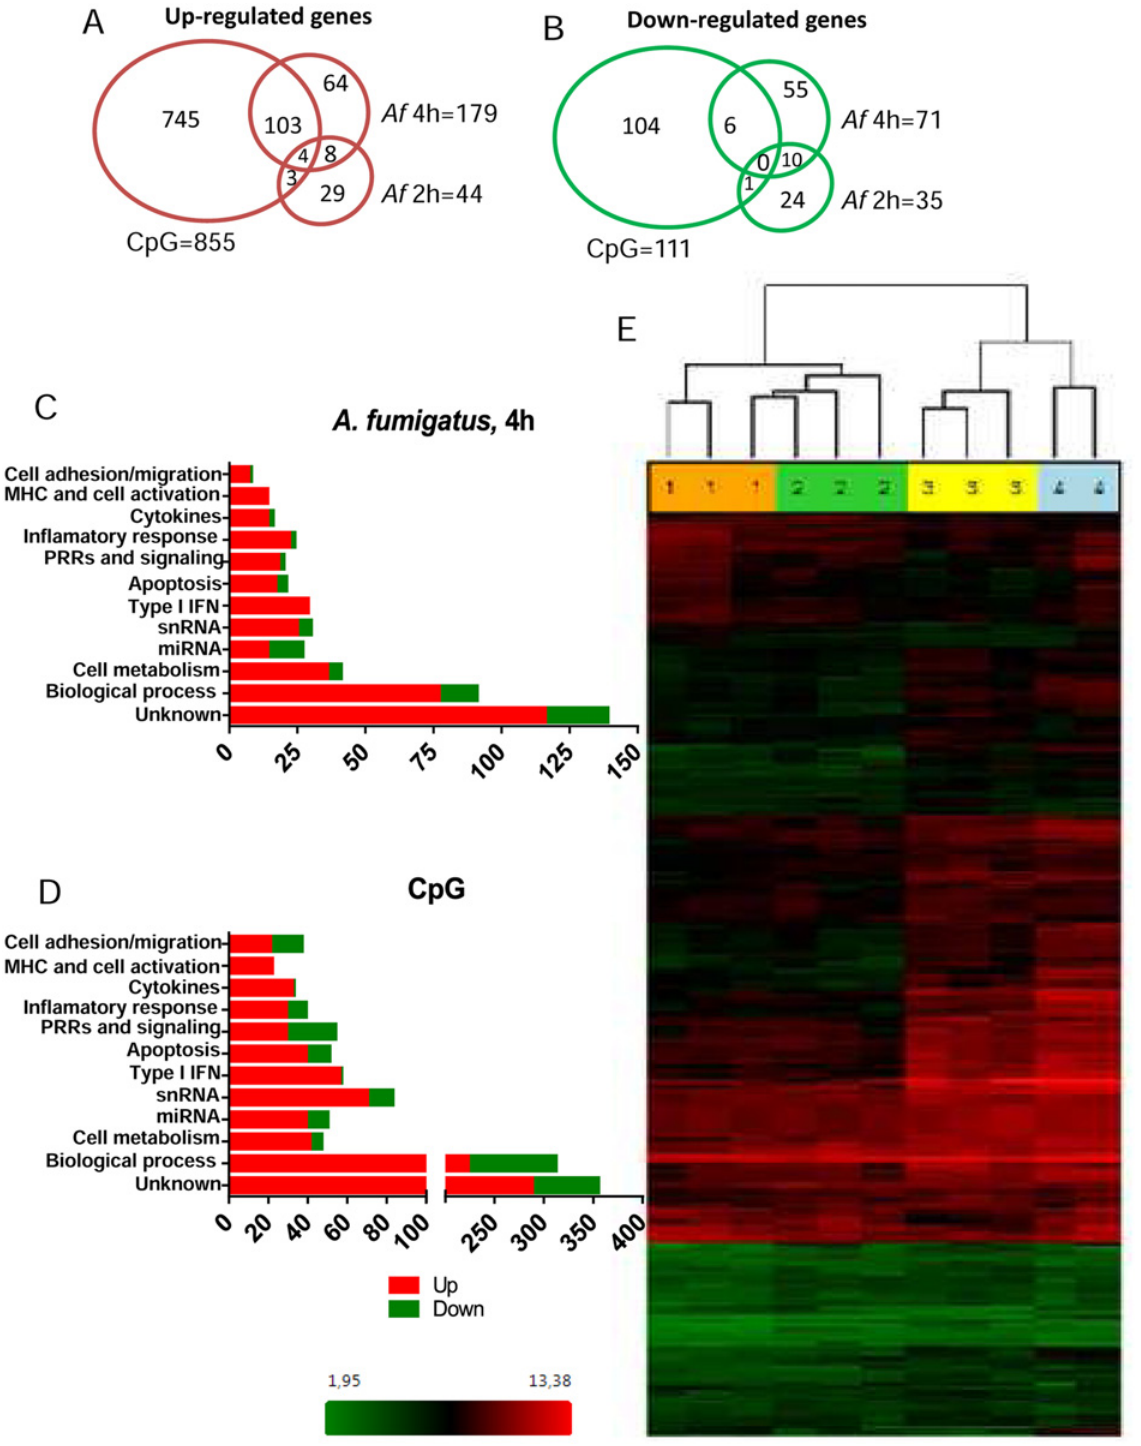
Fig 6. The pDC transcriptome following stimulation with A . fumigatus . Human pDCs (2 × 10 5 ) were left unstimulated or stimulated for 2 or 4 hr with A. fumigatus (Af) hyphae (2 × 10 5 ). As a positive control, pDCs were stimulated with CpG (20 μ g/mL) for 4 hr. The RNA was extracted, converted into cDNA, amplified, labeled, hybridized to microarrays, and analyzed as described in Methods . (A, B) Venn diagrams showing the number of up-regulated and down- regulated genes found in each experimental group as well as the overlap between groups. (C, D) Regulated genes classified in categories according to the NetAffx program. (E) A heat map of the 250 genes (see S1 Table) differentially expressed following hyphal or CpG stimulation. Each column represents